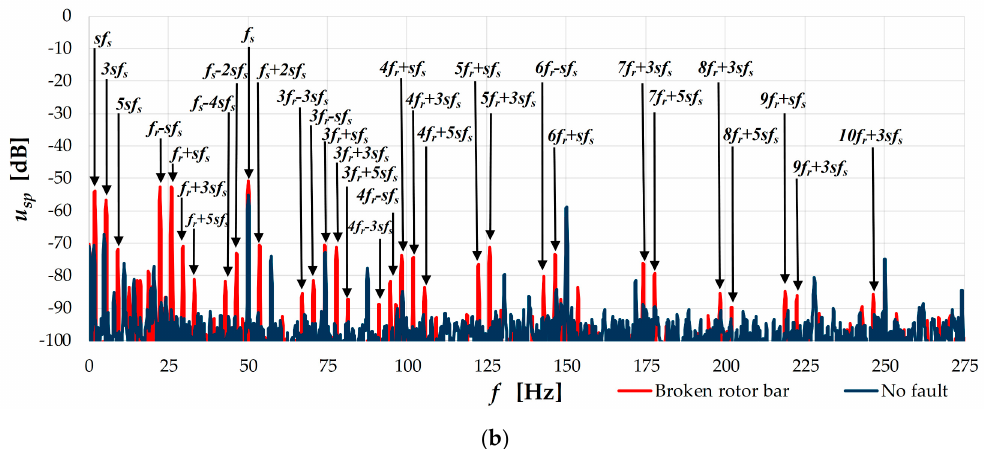
Figure 7. FFT analysis of the axial flux for the nominal load torque and f s = 50 Hz: ( a ) stator winding fault; ( b ) broken rotor bars.